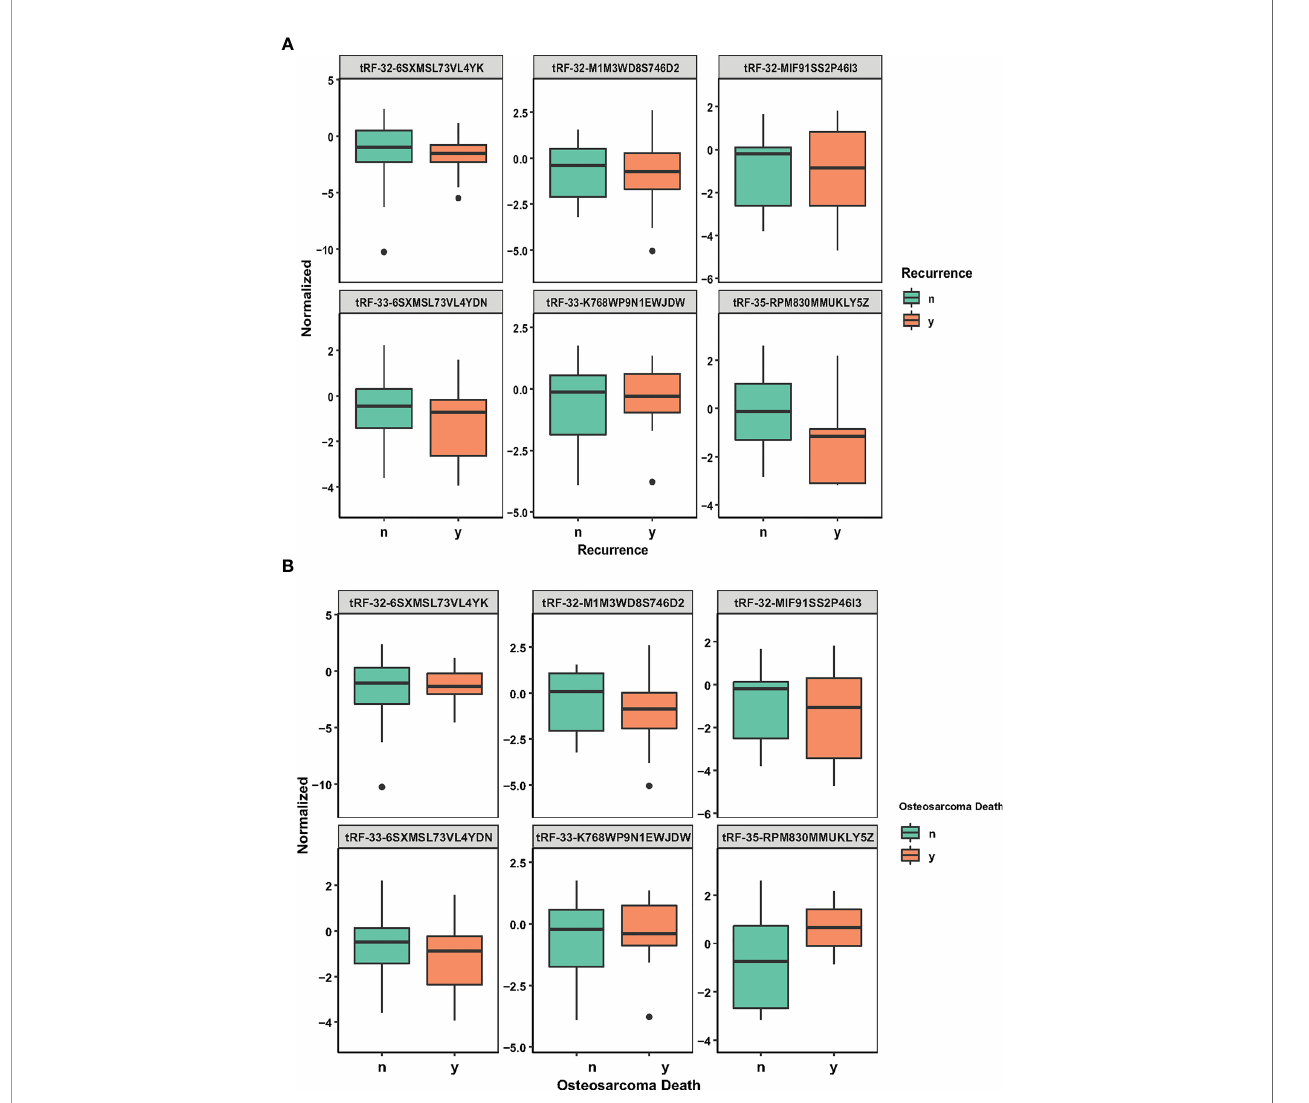
FIGURE 2 | tsRNA expression in recurrence and osteosarcoma death. (A) Six LASSO-selected tsRNA expression levels in patients with recurrence and non- recurrence. (B) Six LASSO-selected tsRNA expression levels in surviving patients and patients with death from osteosarcoma. The lines from top to bottom are tRF- 33-6SXMSL73VL4YDN, tRF-32-6SXMSL73VL4YK, tRF-32-M1M3WD8S746D2, tRF-35-RPM830MMUKLY5Z, tRF-33-K768WP9N1EWJDW, and tRF-32-